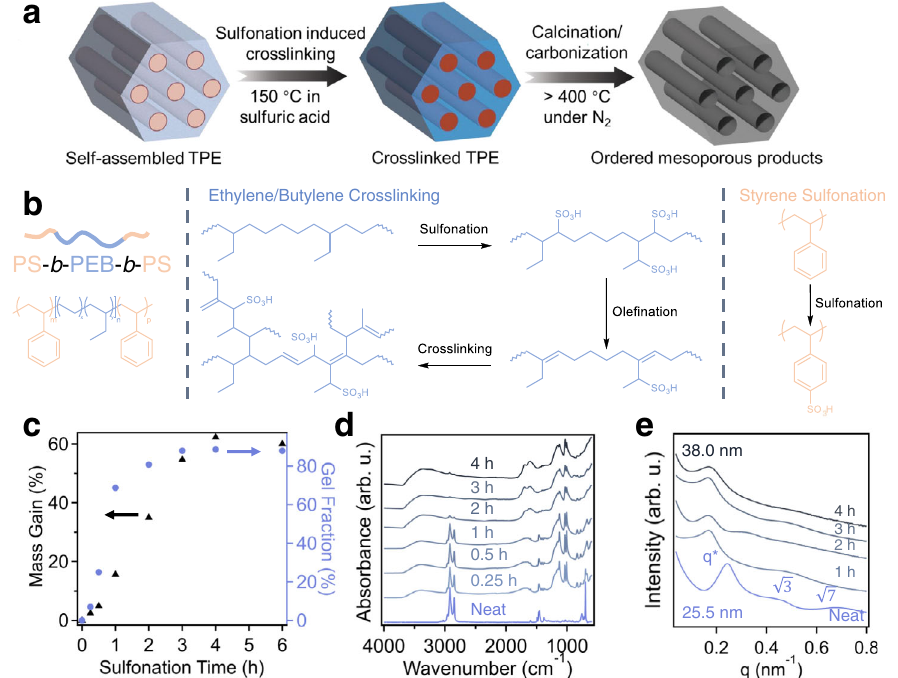
Fig. 1 | Sulfonation-induced crosslinking reaction of SEBS. a Schematic illus- tration of thermoplastic elastomer undergoing a sulfonation induced crosslinking reaction and being converted into a carbon precursor. The precursor is pyrolyzed in inert atmospheres to produce mesoporous products. b Crosslinking reaction schemes for both PEB and PS blocks of the SEBS118 precursor. c Plot of mass gain